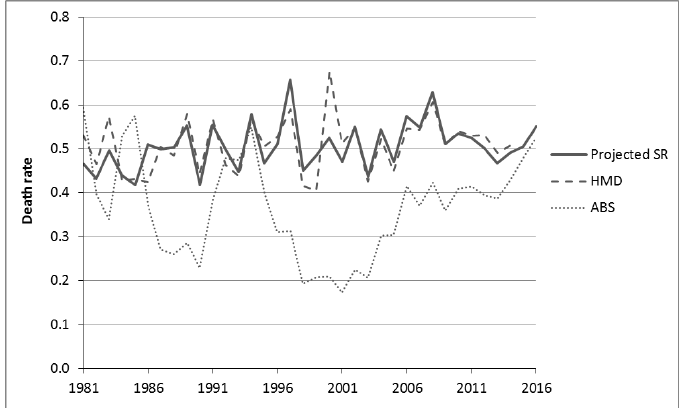
Figure 8: Comparison of male centenarian death rates for Australia,